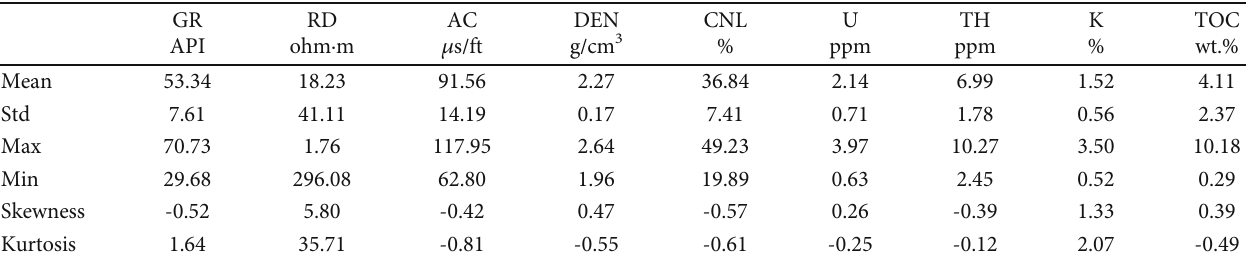
Table 1: Results of the statistical analysis of well S352 well